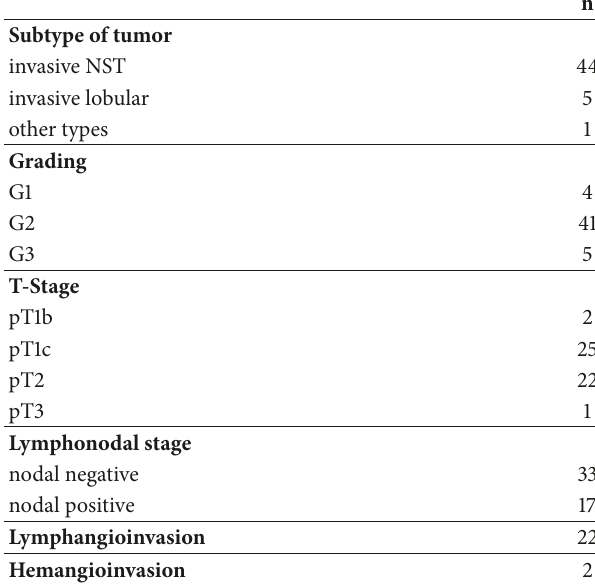
Table 1: Subtypes and stages of included cases of breast cancer. NST = invasive breast cancer of no special type (NST). 17 cases with metastases in only one case.